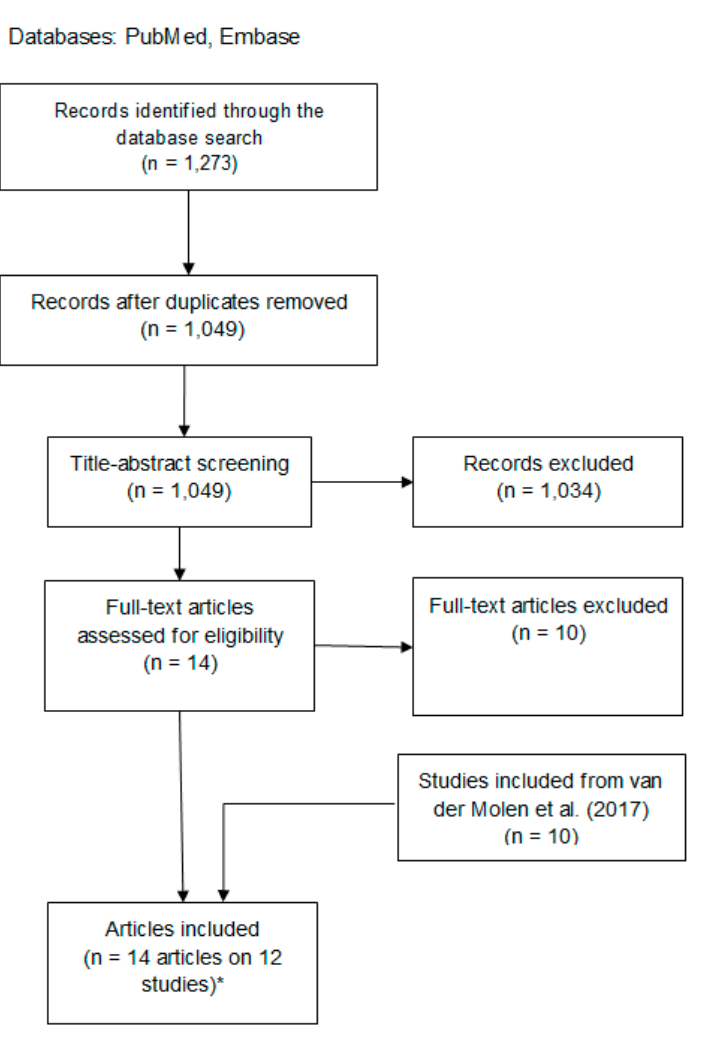
Figure 1. PRISMA Flow Diagram.